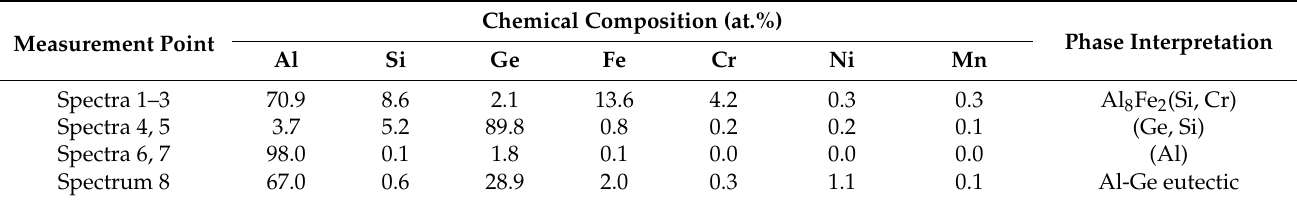
Figure 10. SEM image of the AISI 304/AISI 304 joint brazed according to the 540 °C/30 min mode with the EDX measurement points. Table 5. Results of EDX analysis of the AISI 304/AISI 304 brazed joint.